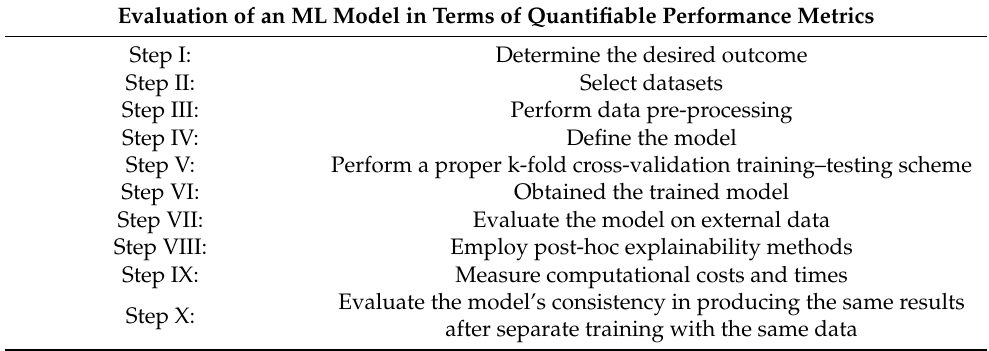
Table 1. A typical procedure for assessing the ML model’s robustness. Evaluation of an ML Model in Terms of Quantifiable Performance